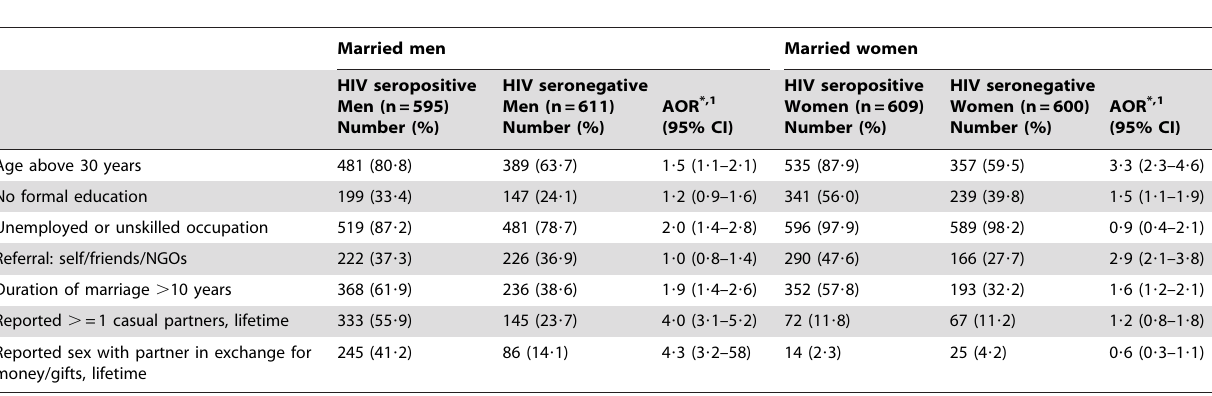
Table 1. Socio-demographic and sexual characteristics of HIV seropositive and HIV seronegative men and women—East and North India,